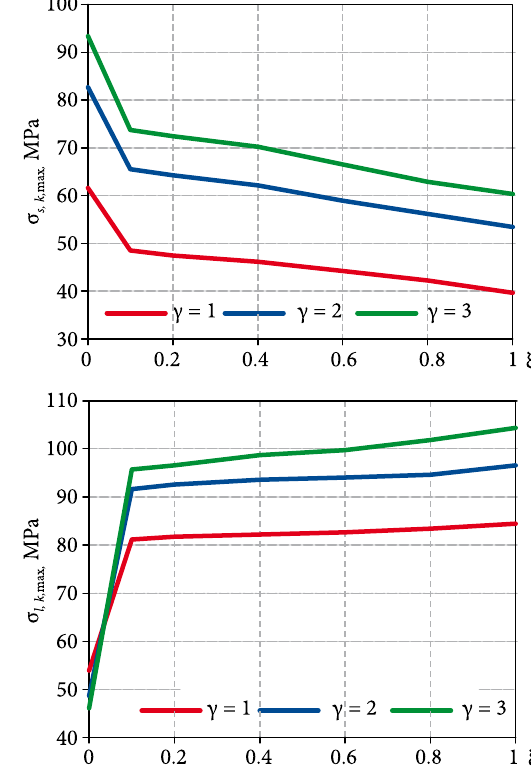
Fig. 9. Max stresses at the quarter point in the stiffening